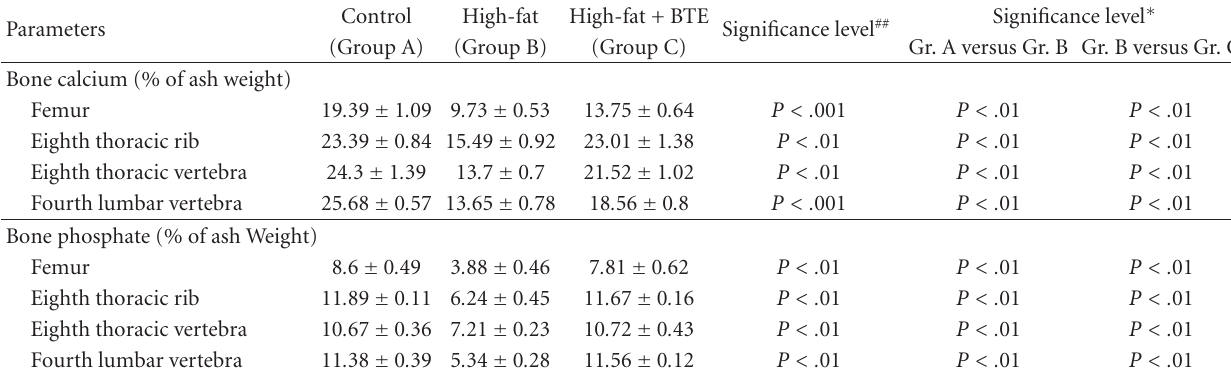
Table 4: Bone mineral content of femur, eighth thoracic rib, eighth thoracic vertebra and fourth lumbar vertebra in control group (Group